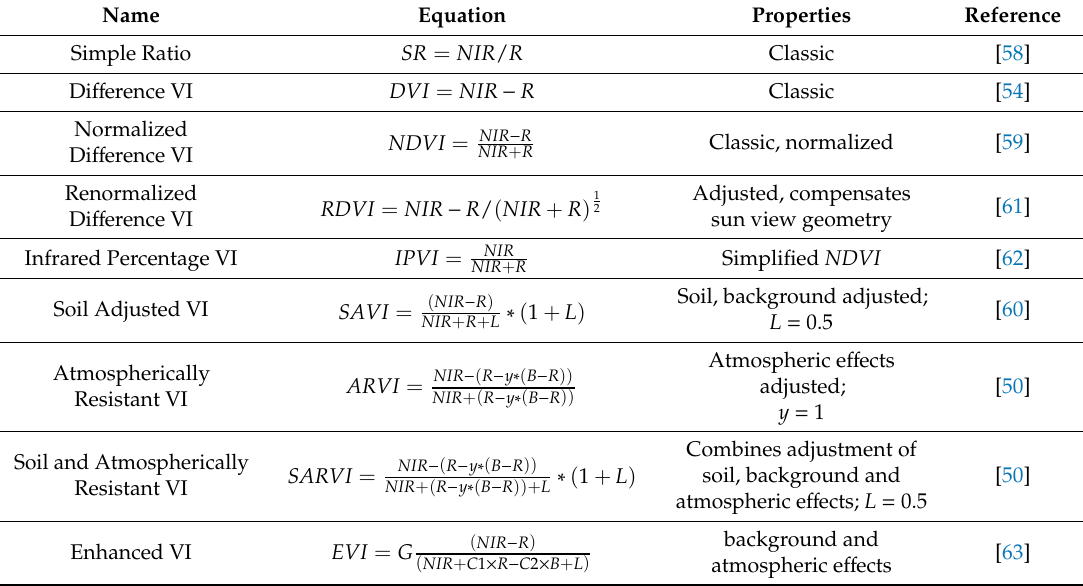
Table 4. Suitable Vegetation Indices and its most important properties used for the mapping of forest